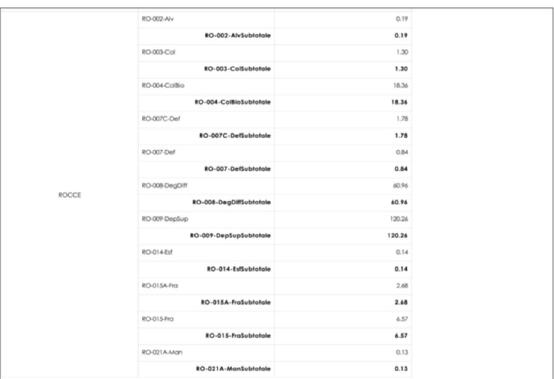
Figure 8. Part of a PDF report automatically generated by EasyCUBE PRO